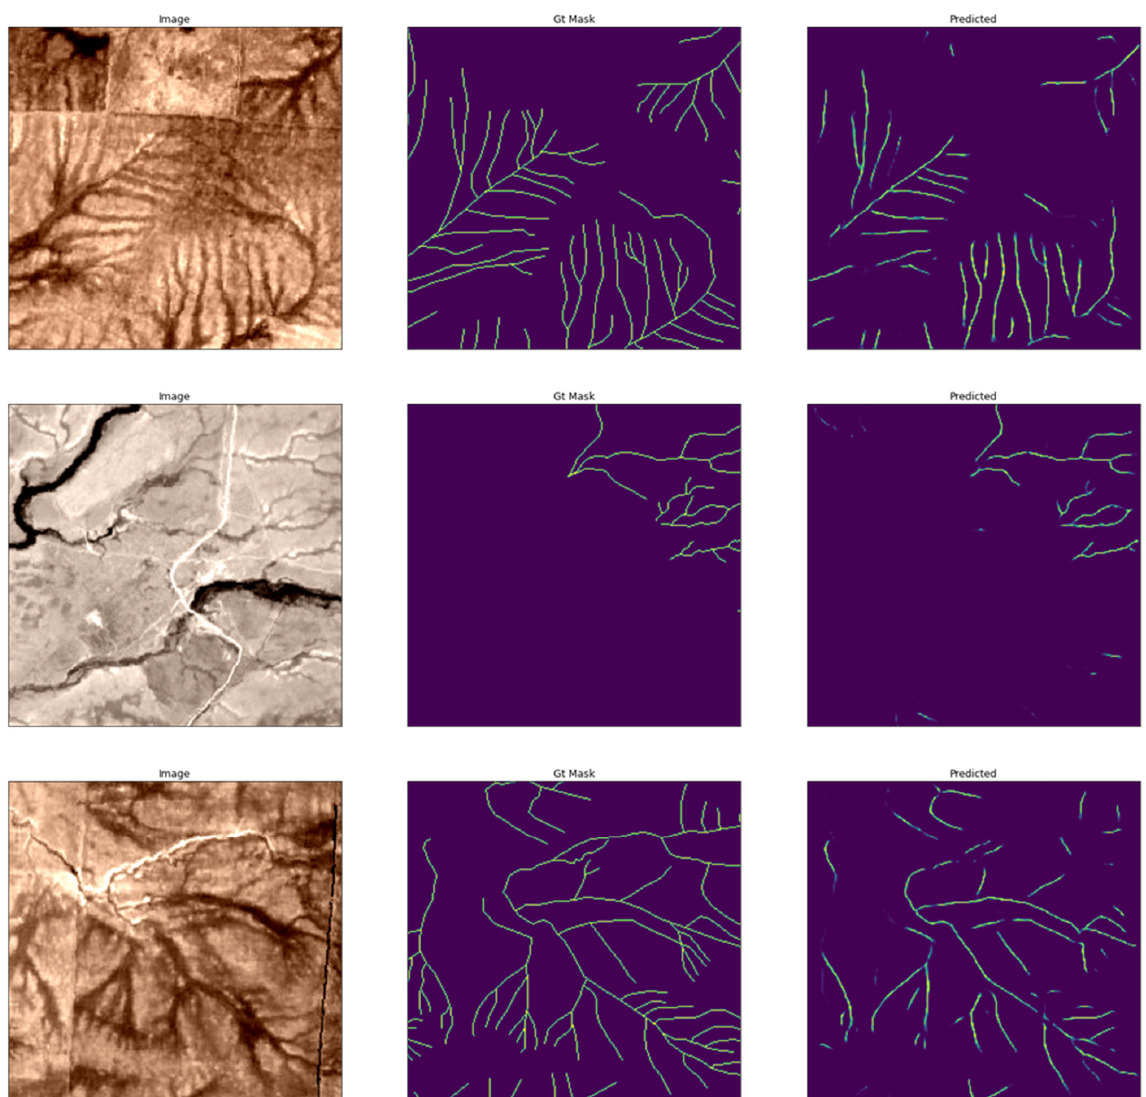
Figure 5. An example of the results of applying RECNN to a test dataset.